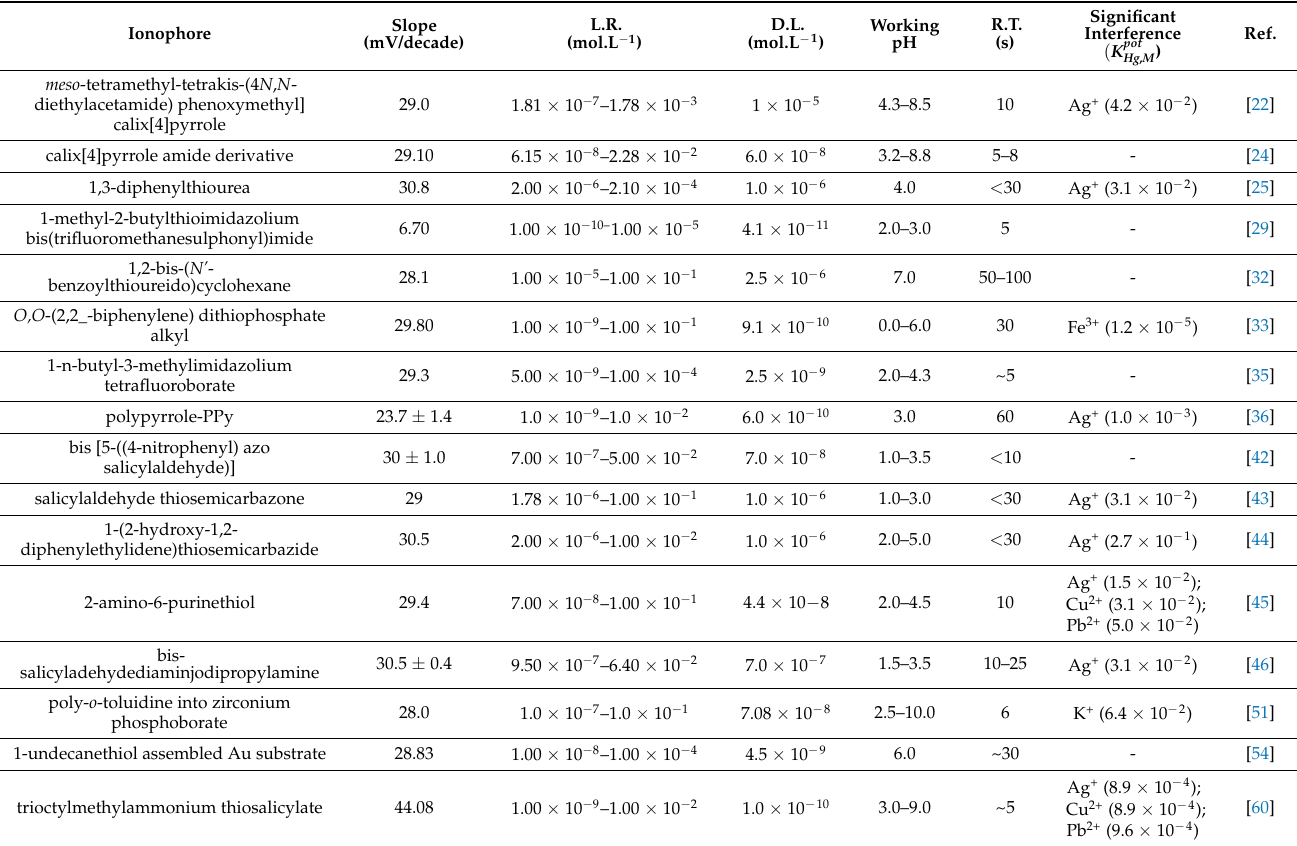
Table 5. Comparison between some responses characteristics of the proposed Hg 2+ -SE based on BMPMP with the previously reported for Hg 2+ -SES based on various ionophores with the reported electrodes.